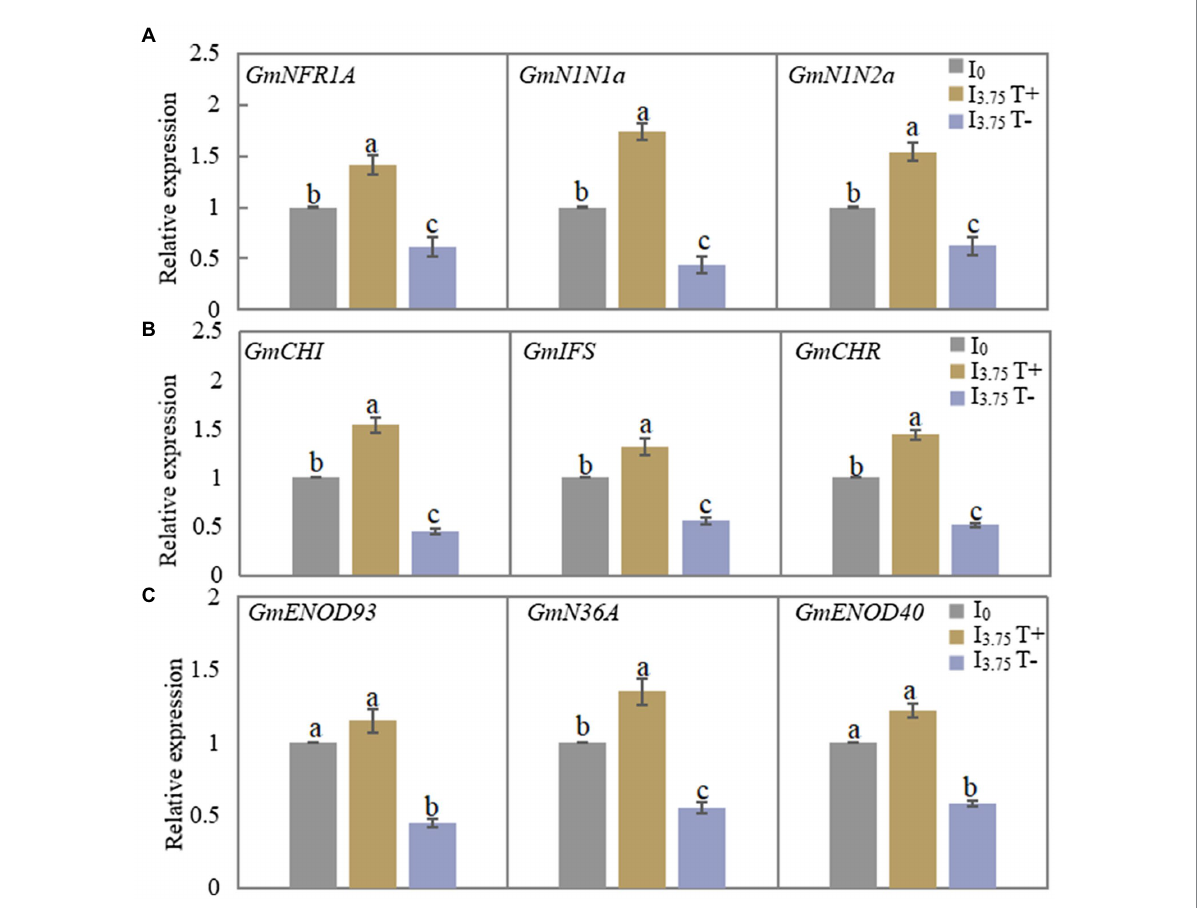
FIGURE 4 Changes of relative expression of nodulation-related genes in roots and nodules of dual-root soybean after unilateral supply of isoflavones, different lowercase letters above the bars indicate significant difference ( p < 0.05) by Duncan’s multiple range test. I 0 refers to conventional nutrient solution applied on both sides; I 3.75 T+ is the treatment side of unilateral application of nutrient solution containing daidzein and genistein, and I 3.75 T-is the untreated side of the unilateral application of nutrient solution that contained daidzein and genistein. (A) The expression level of the nodulation signal recognition gene on both sides of dual-root soybean after treatment for 3 days. (B) The level of expression of the genes for roots isoflavone synthesis on both sides of the dual-root soybean after 7 days of treatment. (C) The level of expression of the genes of early nodulin synthesis in root nodules after 21 days of